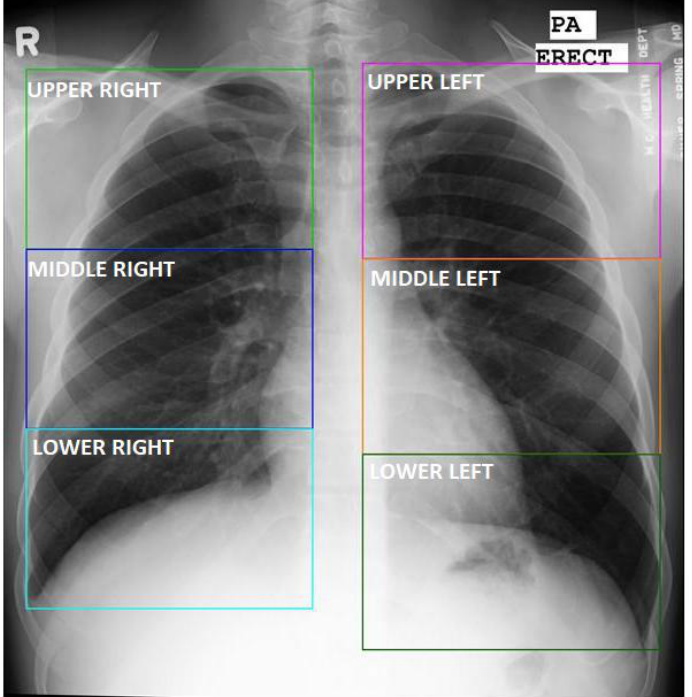
Figure 2. Definition of six lung sextants. Abnormal annotations are assigned to one or more of these sextant